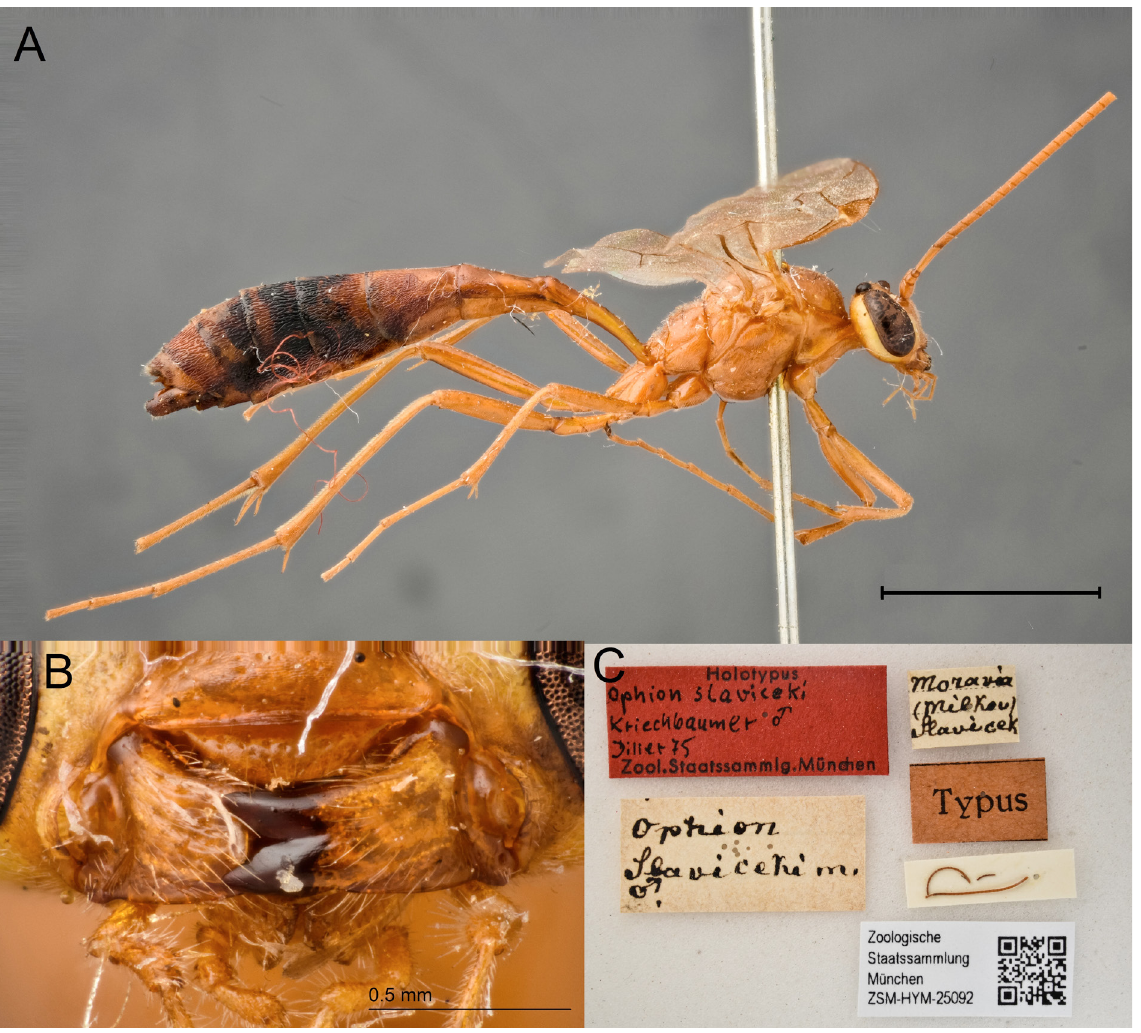
Fig. 46. Ophion slaviceki , 1892, holotype, ♂ (ZSM). A . habitus, lateral view. B . Mandibles, anteroventral view. C . Labels. Scale bar: A = 5 mm; B = 0.5